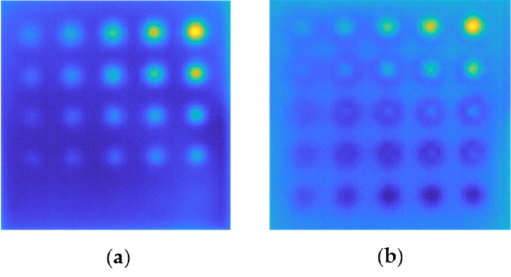
Figure 12. The result of the trend removal shown for the sample S1 ( a ) and S2 ( b ).